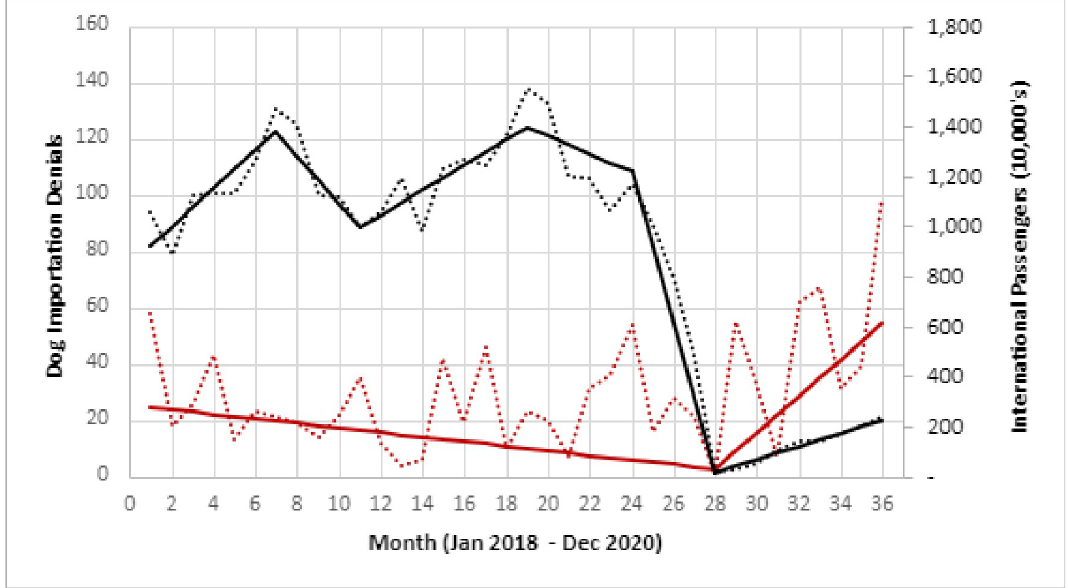
Fig 2. Trends in the number of dogs denied entry and number of travelers arriving into the United States, 2018–2020 � † . � Black dotted line reflects the monthly number of travelers arriving in the United States. The solid line represents the modeled values from trend analysis. † Red dotted line reflects the monthly denial of dogs at CDC quarantine stations. The solid red line represents the modeled values from trend analysis and show two trend periods (January 2018 –April 2020) and (April 2020 –December 2020).